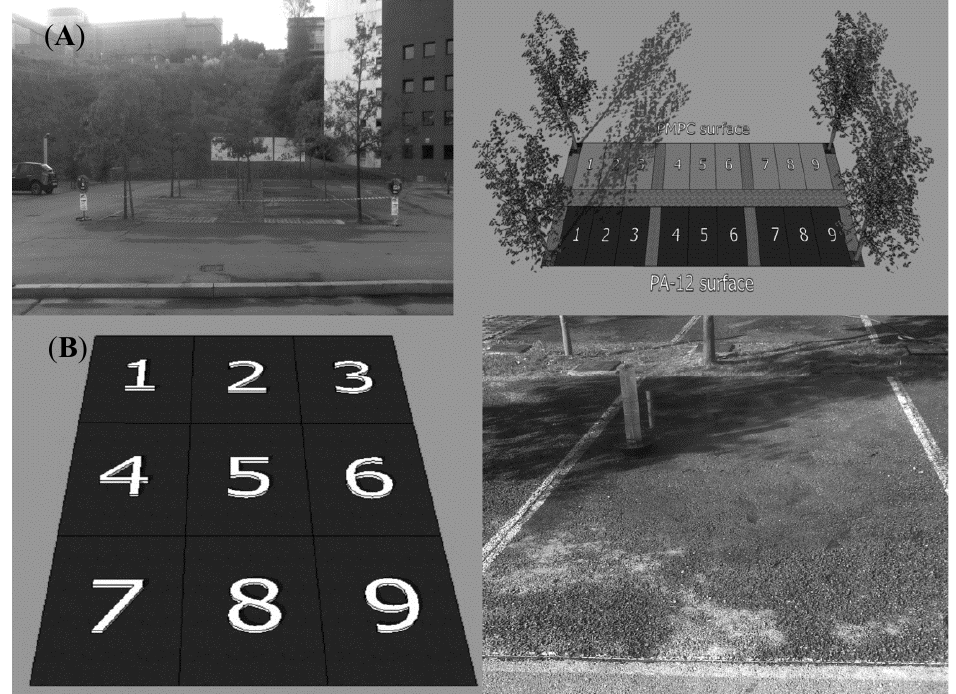
Figure 1. ( A ) Scheme of the eighteen car parking bays analyzed; and ( B ) measurement zones selected within each car park bay and LCS